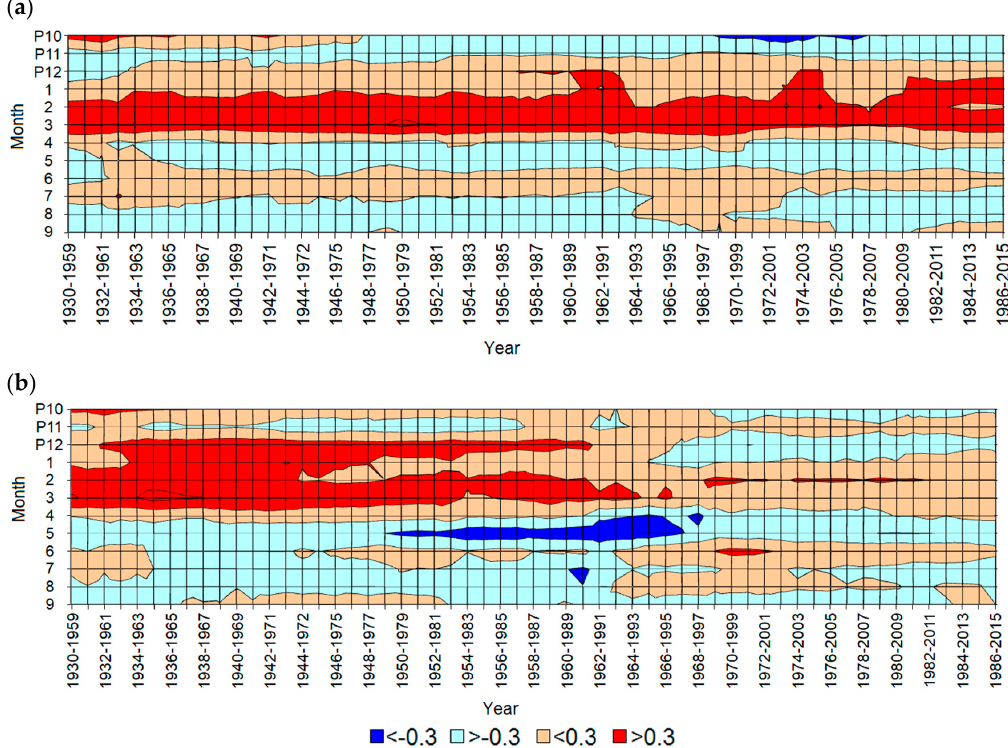
Figure 7. Analysis of the moving correlation for the relation of Scots pine site chronologies—PSO176f (control) ( a ) and PSO142d ( b ) with the mean air temperature 1930–2015. Notes: P—previous year. The Pearson’s correlation coefficient at α ≤ 0.1 and for N = 30 is ±0.296, where N is the number of degrees of freedom.